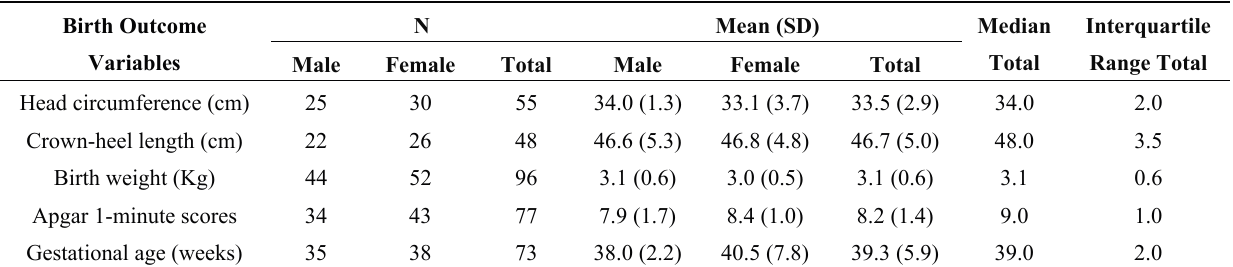
Table 3. Descriptive analysis of continuous birth outcome variables stratified by sex of